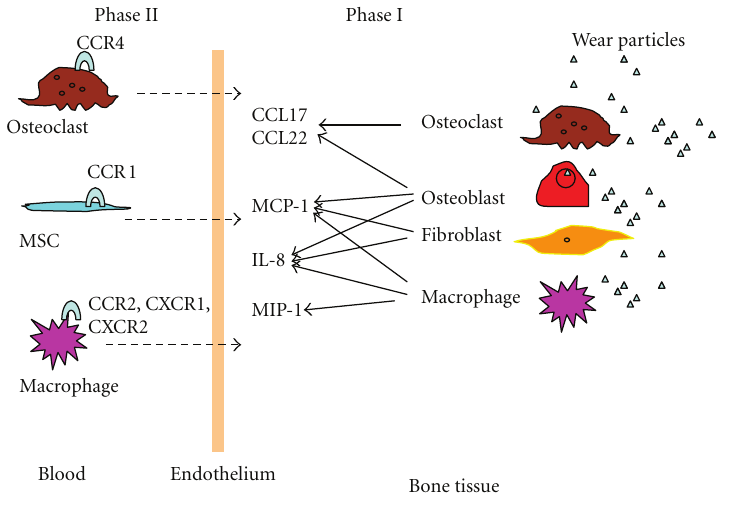
Figure 2: Wear particles induced chemokine expression and cellular